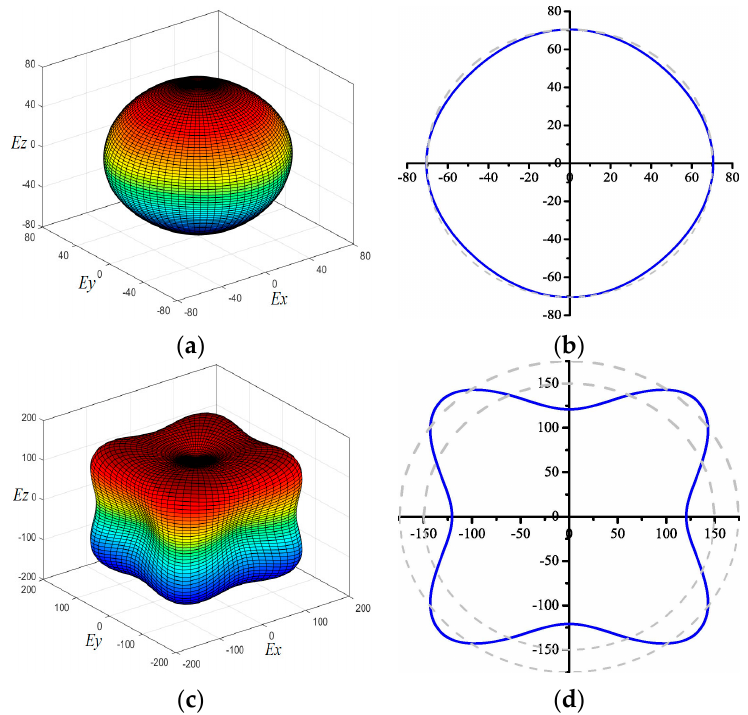
Figure 5. The directional dependence of Young's modulus for Si 96 ( a ) and diamond Si ( c ); and a 2D representation of Young’s modulus in the xy plane for Si 96 ( b ) and diamond Si ( d ).